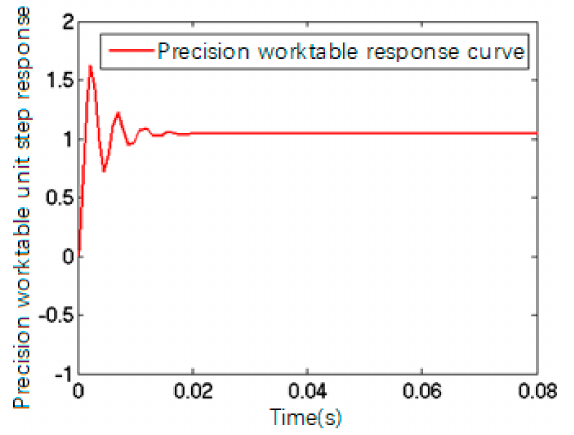
Figure 7. The response curve of PZT mathematical